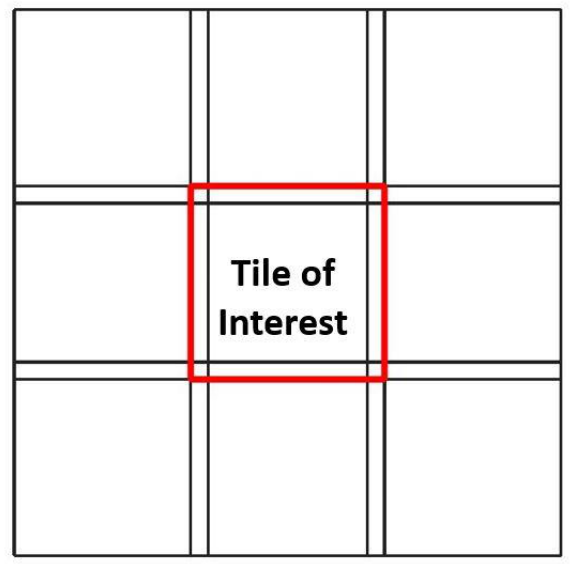
Figure 11: Tile of interest used to identify neighboring tiles b) The overlap between the tile of interest and neighboring tile area is clipped for all adjacent tiles. (Fig. 12)